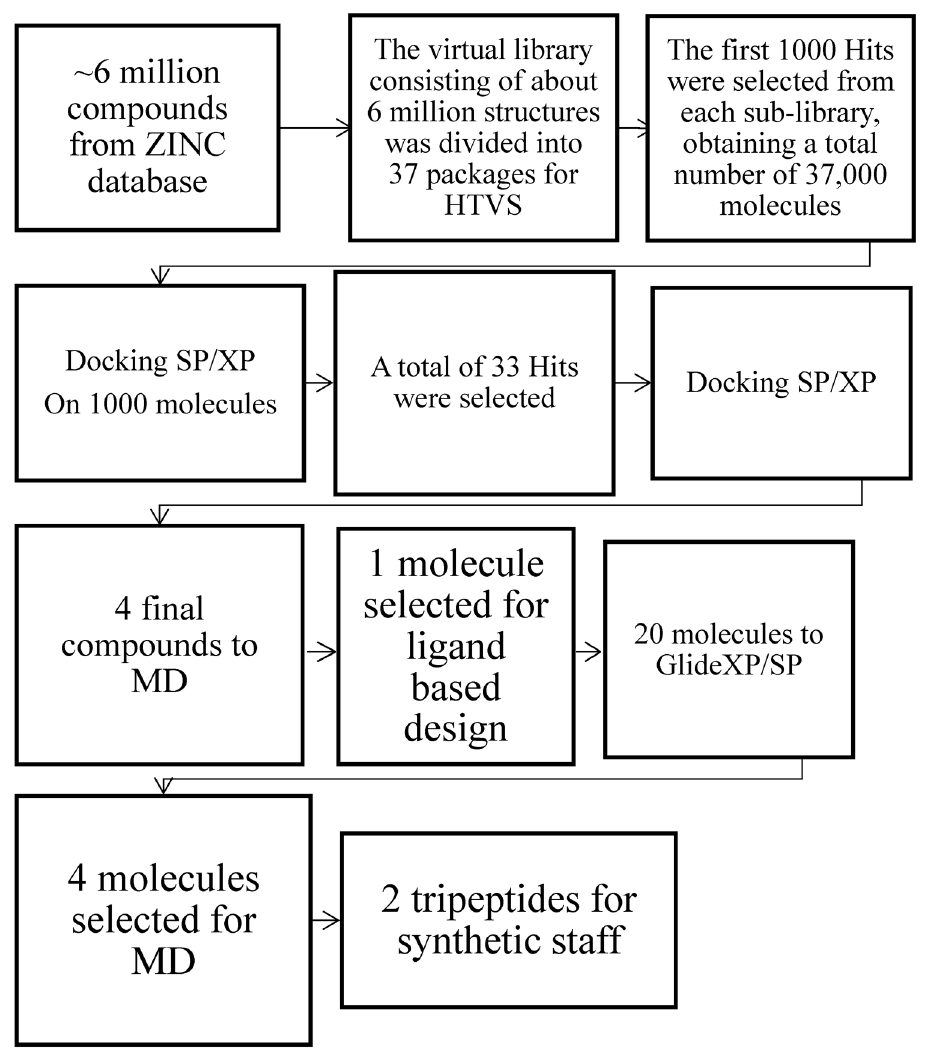
Figure 1. Computational workflow for the identification of the best two hits via Glide XP/SP and MD